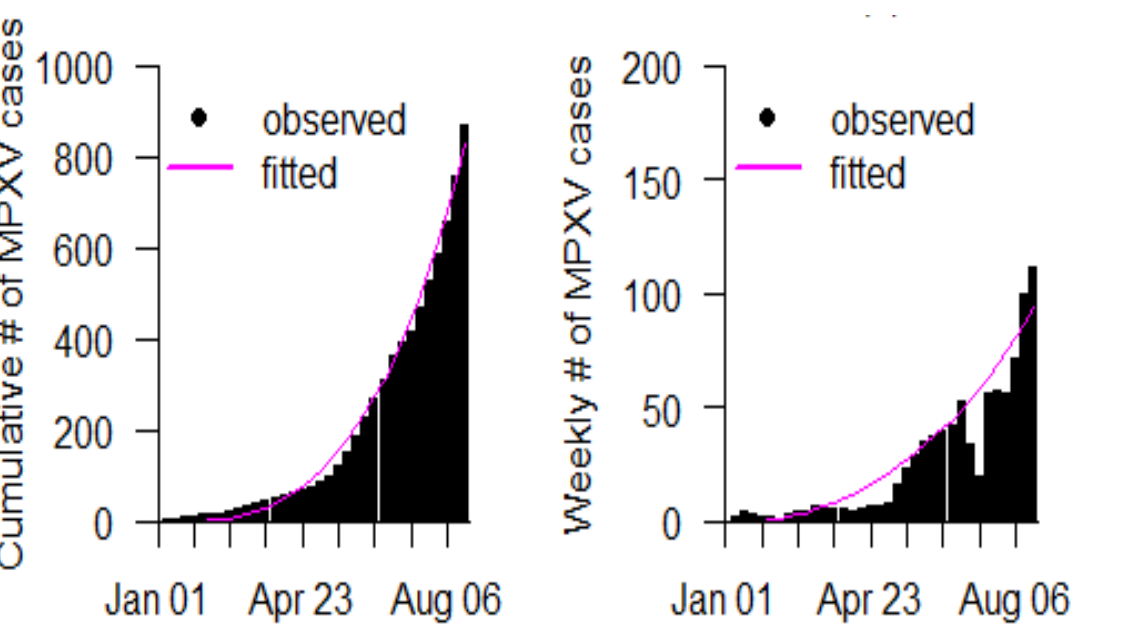
Figure 2. The outcome of model fittings for the mpoxv outbreak in Nigeria. The black dots represent the real mpoxv scenario, and the purple curve represents the mpoxv model’s